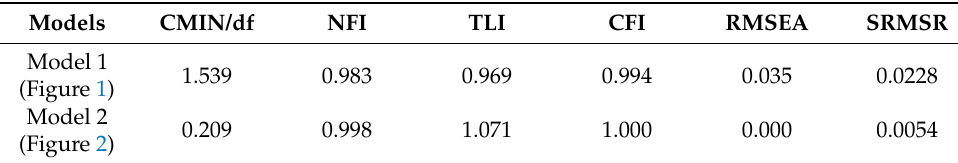
Figure 2. Mediation of PSYSOLOSS in the relationship between personality and life satisfaction. Table 3. The overall goodness of fit statistics for the